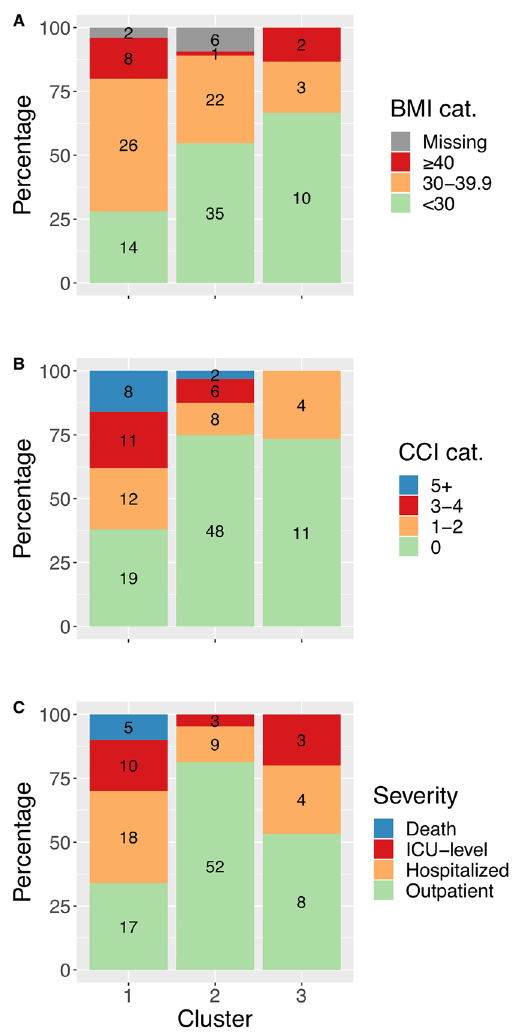
Figure 2. Cluster differences with bar plots (% [n]) of comorbid diseases and severity by cluster. ( A ) BMI (body mass index) category (range in kg/m 2 ) prevalence by cluster; ( B ) Charlson Comorbidity Index (CCI) category prevalence by cluster; ( C ) peak levels of severity by cluster. Total (n) presented in the center of each category.